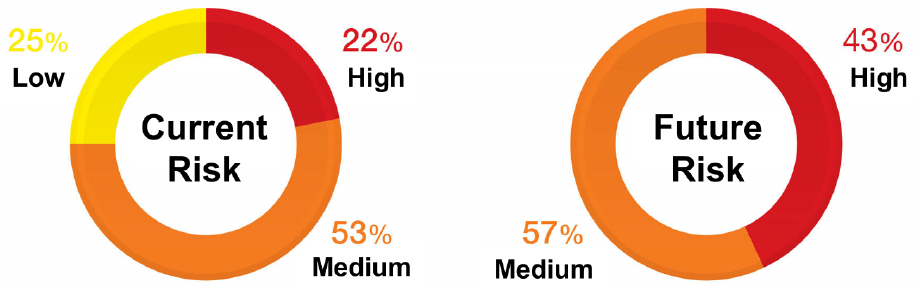
Figure 2. Current and future risks to the attack vector of connected cars. In the future, most attack vectors will shift to medium–high risk